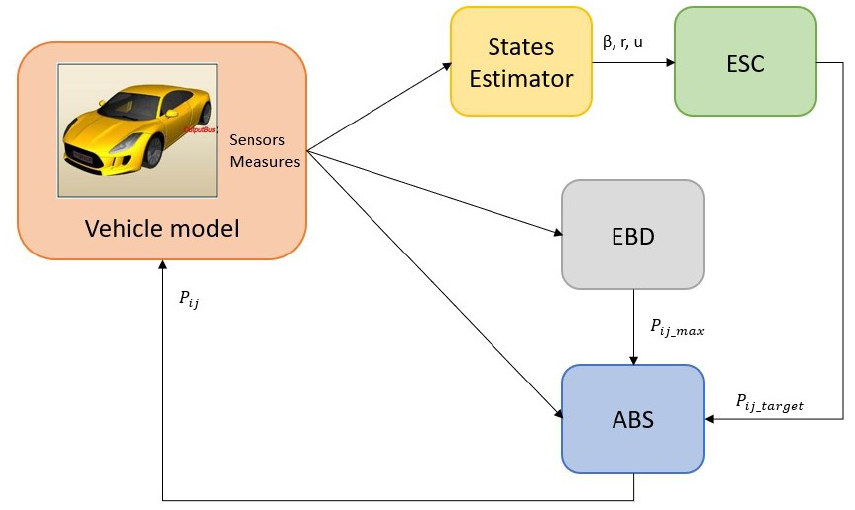
Figure 1. Global vehicle